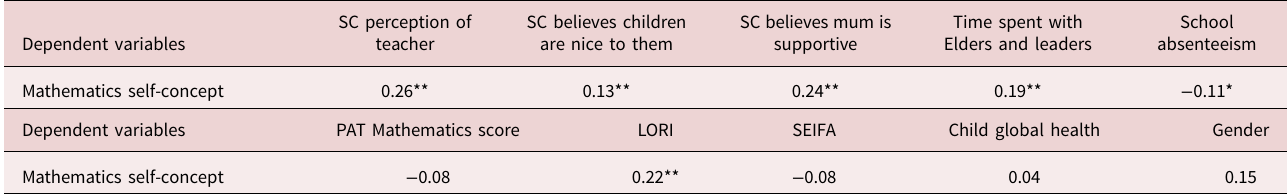
Table 2. Reading self-concept ×selected independent variables